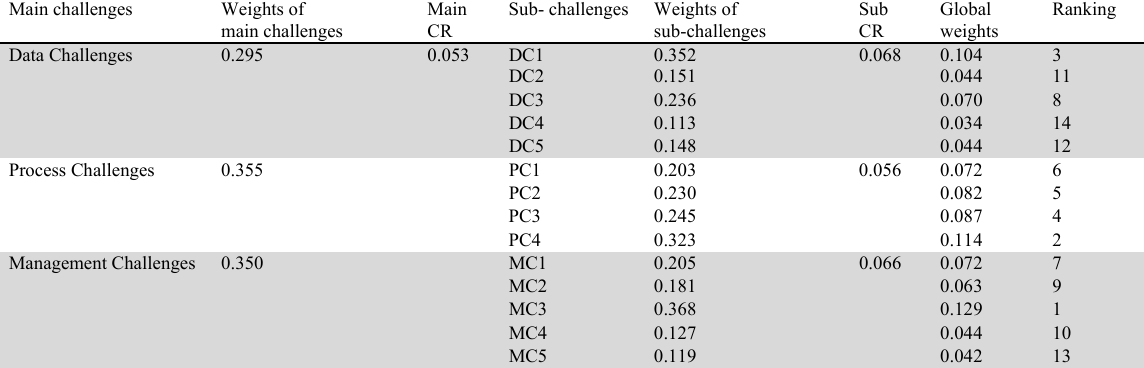
Aggregate weights of main challenges and sub-challenges Main challenges